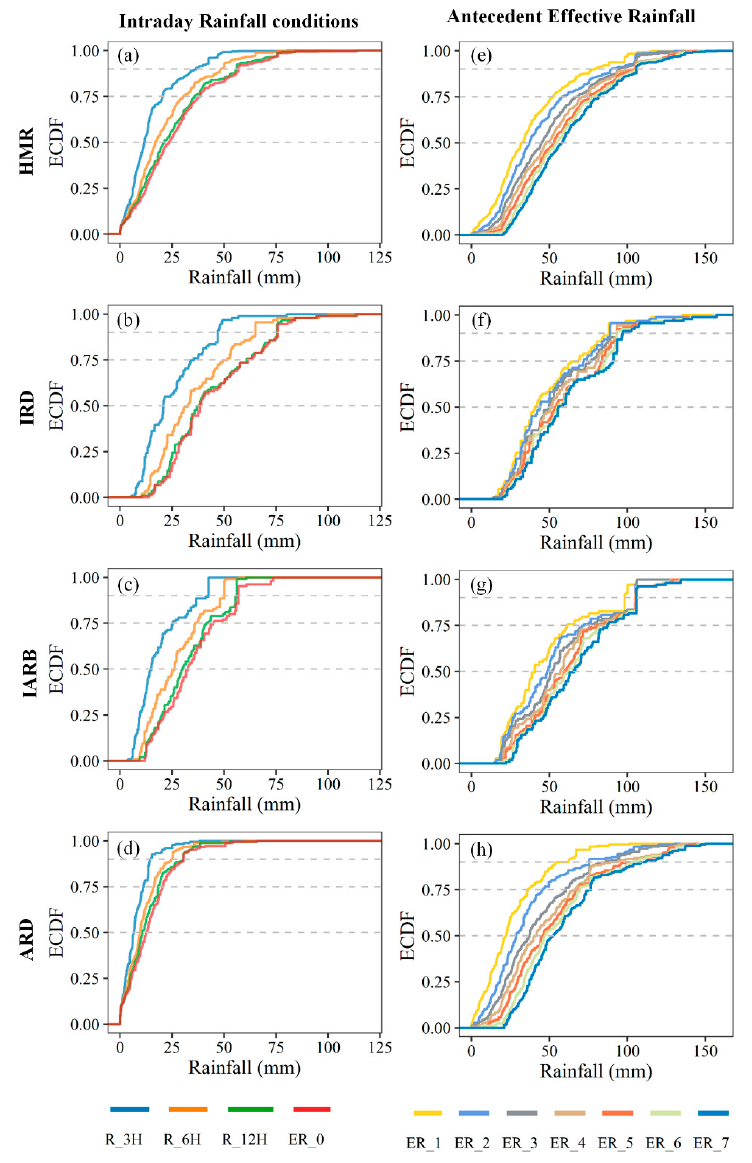
Figure 7. ECDF curves of intraday rainfall conditions ( a – d ) and cumulative 7-day effective rainfall conditions ( e – h ). conditions ( e – h